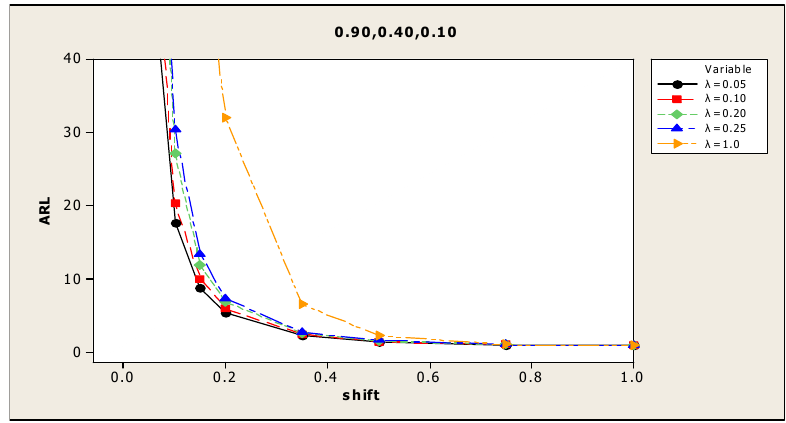
Figure 5. ARL curves when ρ yu = 0.9, ρ yv = 0.4, ρ uv = 0.1 at above values of λ .